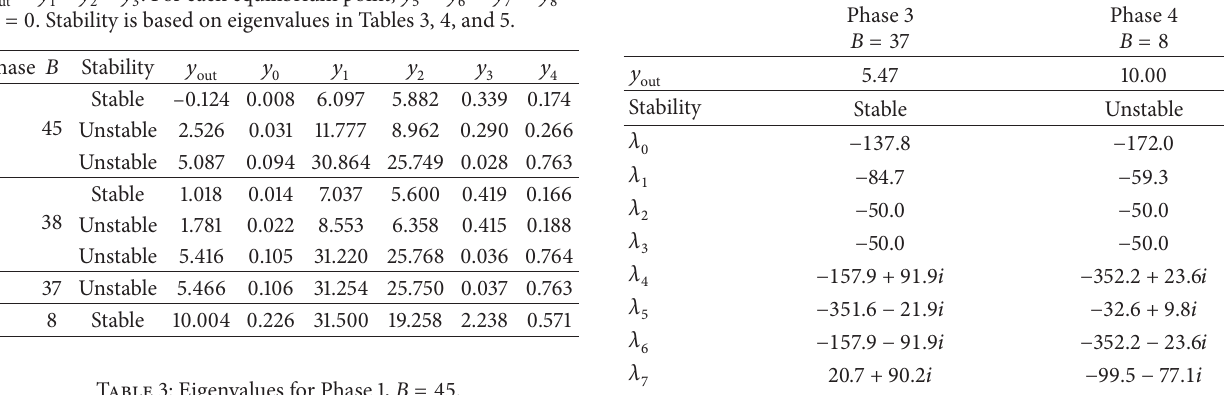
Table 2: Equilibrium points and their stabilities for specific phases. 𝑦